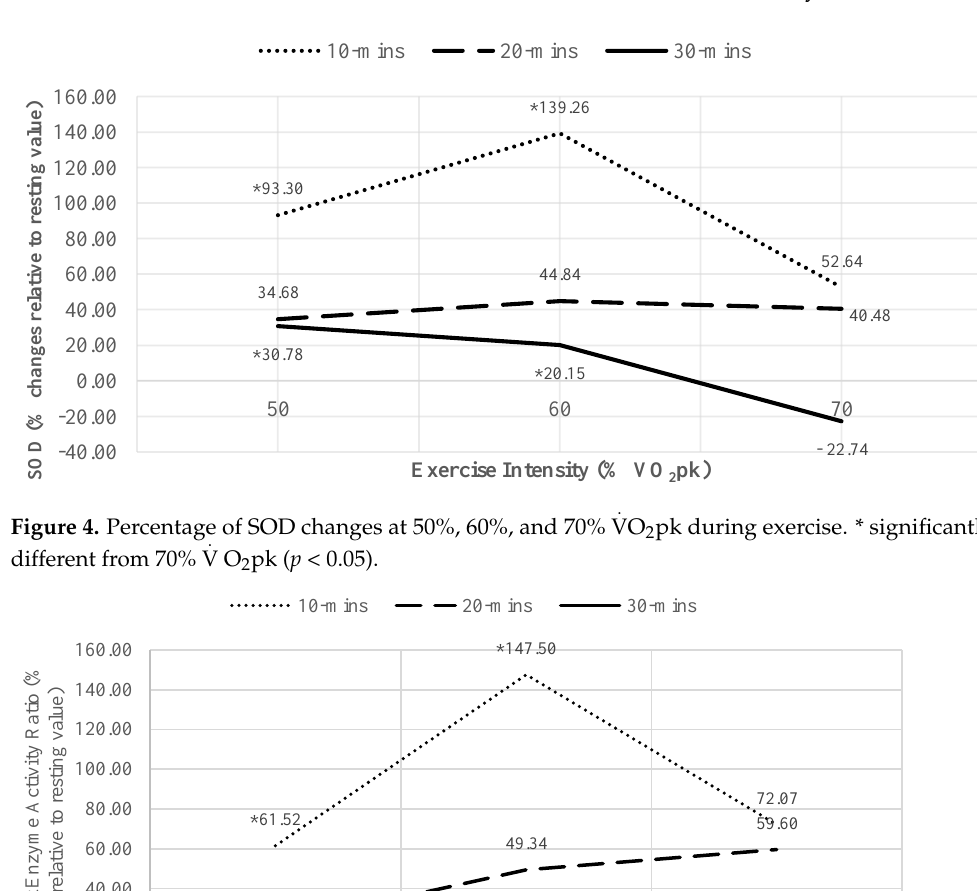
Figure 3. Percentage of GPx changes at 50%, 60%, and 70% V̇ O 2 pk during exercise.